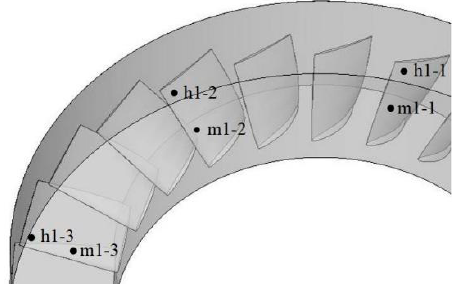
Figure 7. Distribution of the numerical probes in the first stage rotor.